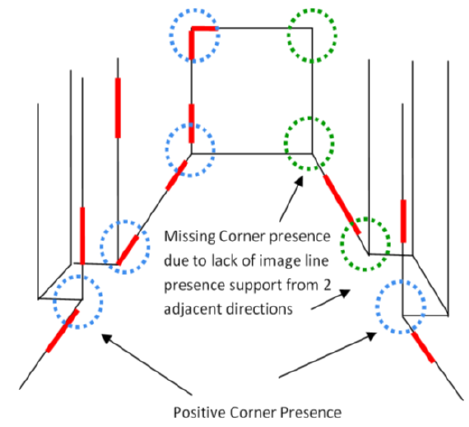
Figure 9. Virtual Corner presence for Indoor